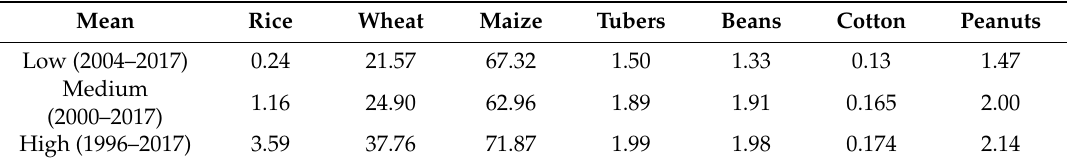
Table 3. Averaged agricultural yields (10 4 t) of di ff erent crops.